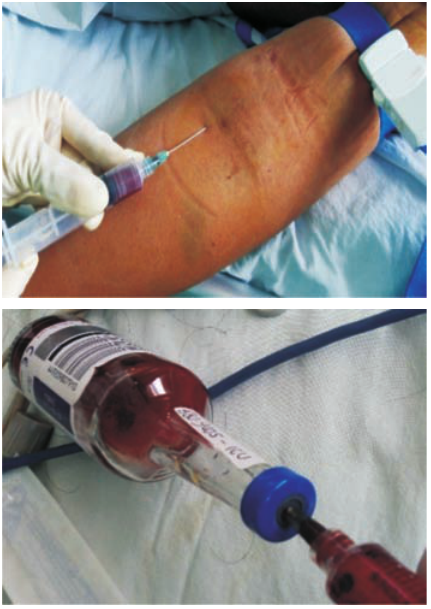
Figure . Special handling specimen of blood in endocarditis